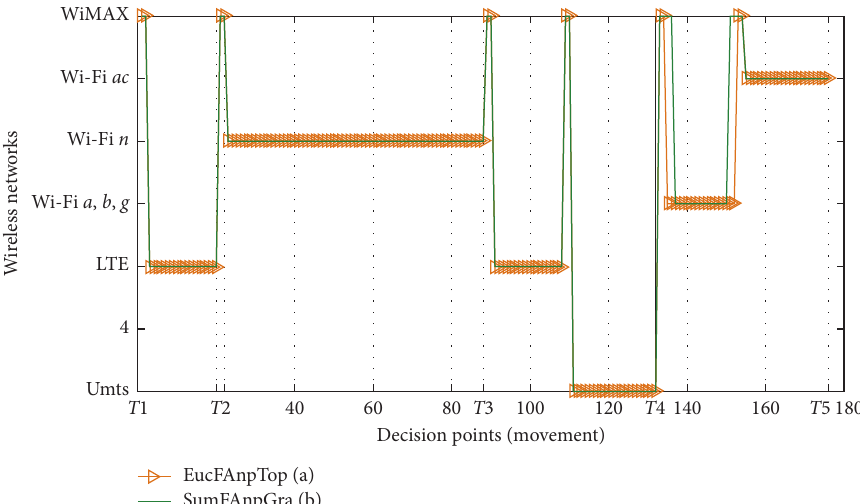
Figure 4: Decisions made during the movement scenario using TOPSIS-FANP (a) and Sum-GRA-FANP (b) combinations.